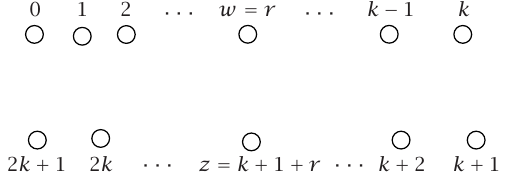
Figure A.1 . Arrangement of vertex labels of snake P